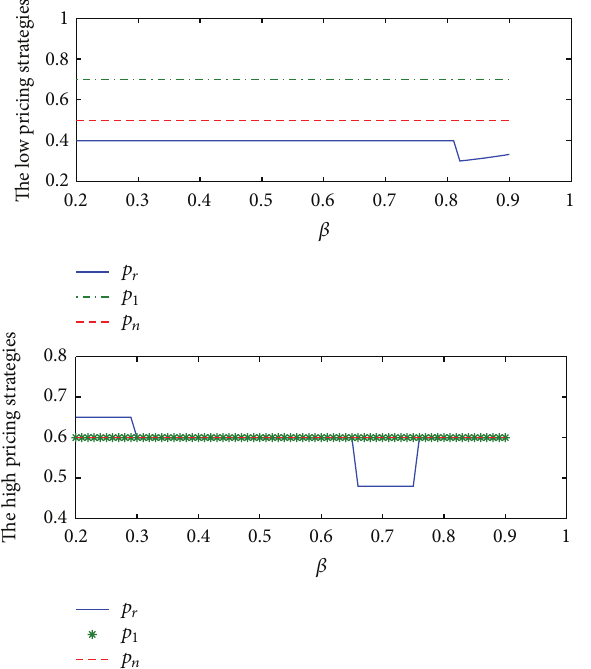
Figure 3: The pricing strategy according to the low disassemblabil- ity.